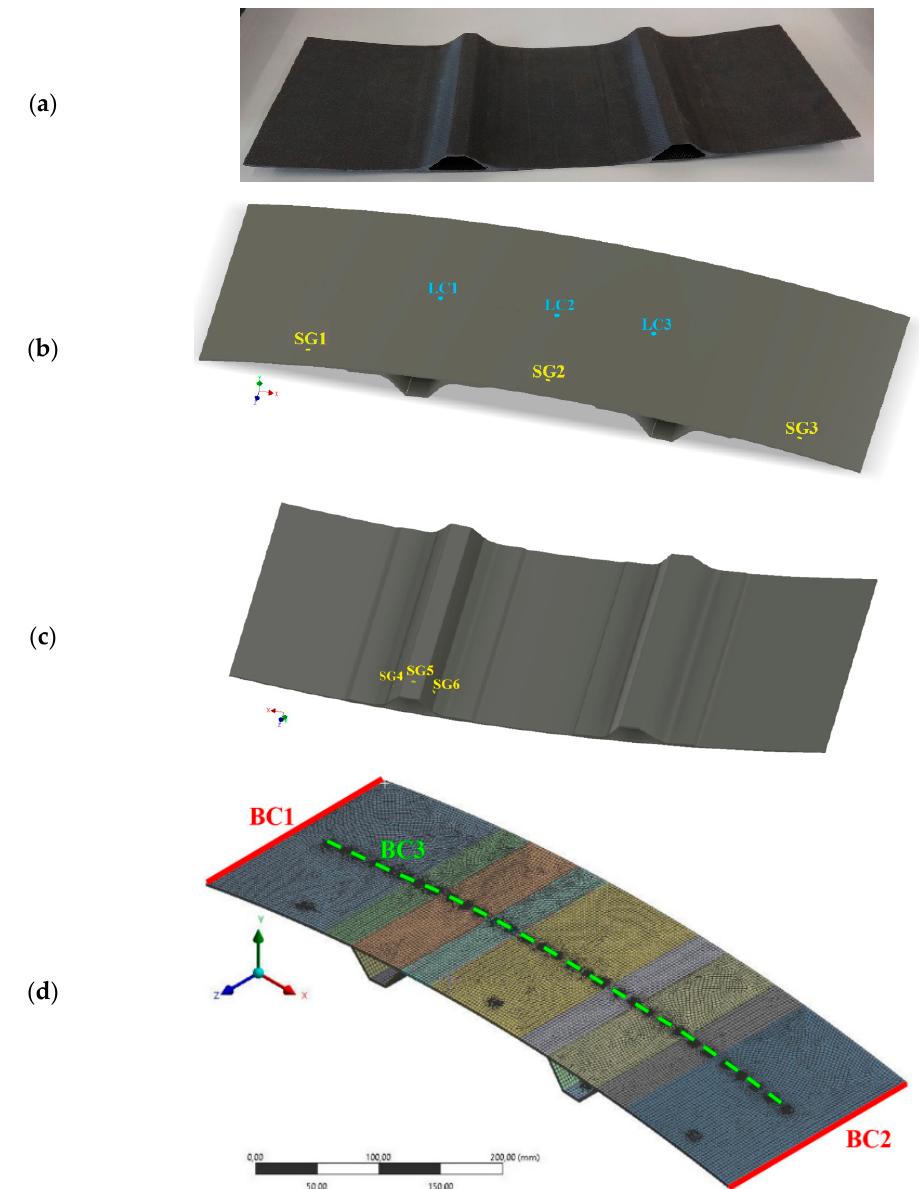
Figure 1. Considered aerostructure: ( a ) photograph, ( b ) top strain gauges SG1–SG3 positions and load points LC1–LC3, ( c ) bottom strain gauges SG4–SG6 positions, ( d ) finite element model and boundary conditions. Reprinted from [15].